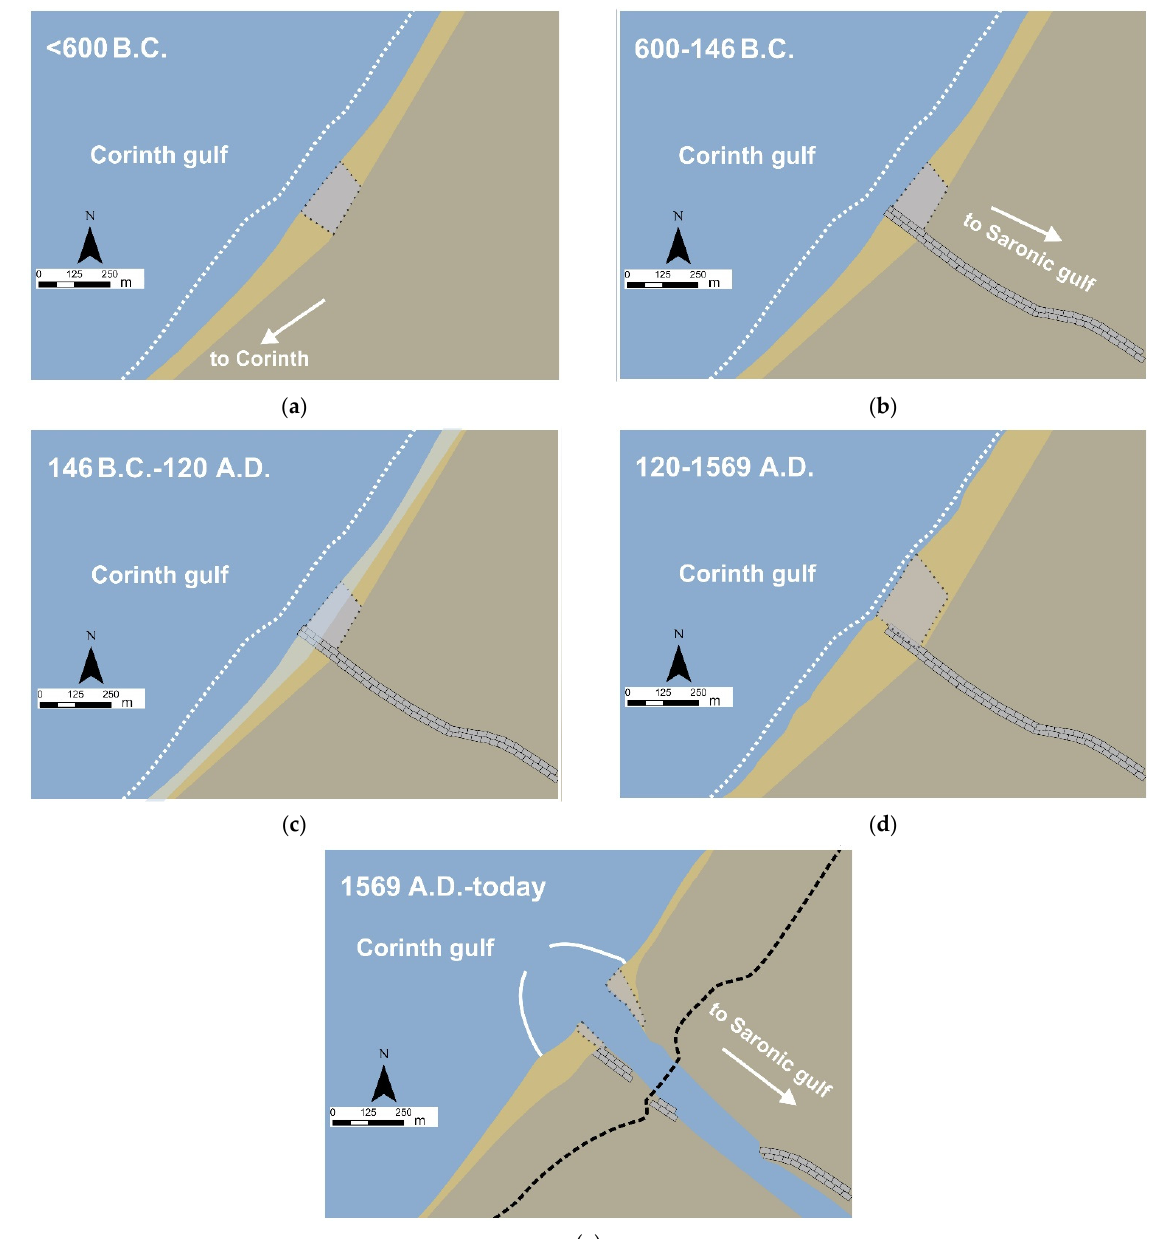
Figure 7. An illustration of the paleogeographic evolution of Diolkos area before the slipway con- struction until today. The white dashed line indicates the modern coast, the grey rectangle indicates the formed beachrocks, the grey blocks indicate Diolkos slipway, the black dashed line indicates the modern road of Posidonia, and the white lines indicate jetties. ( a ) The coastal zone of Diolkos area before the construction of the slipway (<600 B.C.), indicating the beachrock A. ( b ) Construction of Diolkos slipway on the beachrock A. ( c ) Subsidence of beachrock A and Diolkos slipway. ( d ) The new sediments overlay Diolkos slipway and form the beachrock B. The coast has advanced towards se € . ( e ) The coast reached today’s position as the Corinth canal has been opened, and the majority of the beachrock is